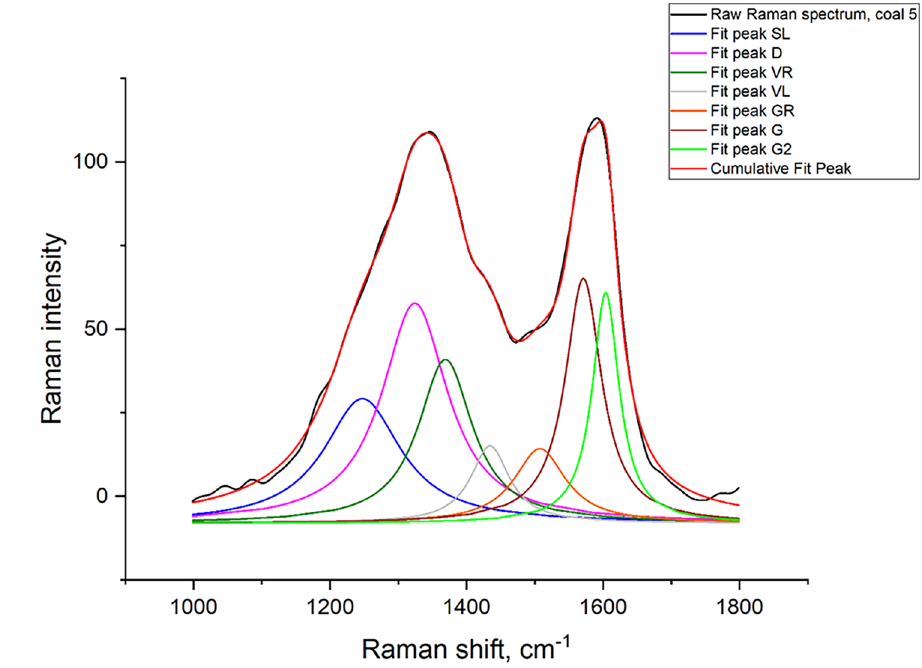
Fig. 2 Example of peaks fitting of the Raman spectral data (for coal No.